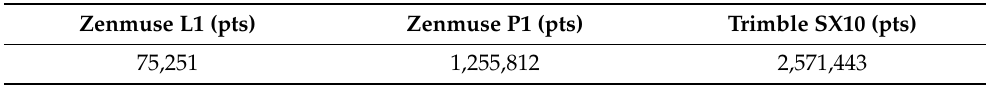
Table 5. Point cloud data related to the tower captured by tested